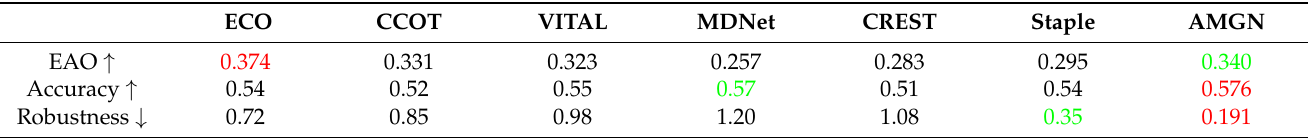
Table 1. Quantitative comparison results on the VOT2016 dataset. Values in red and green indicate the best and the second-best performance,